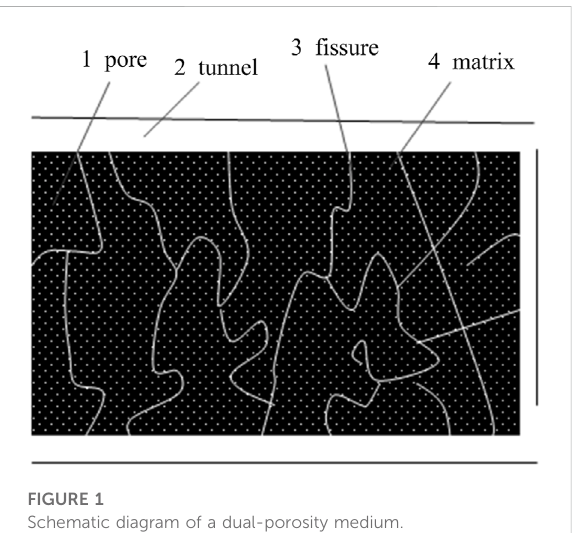
FIGURE 1 Schematic diagram of a dual-porosity